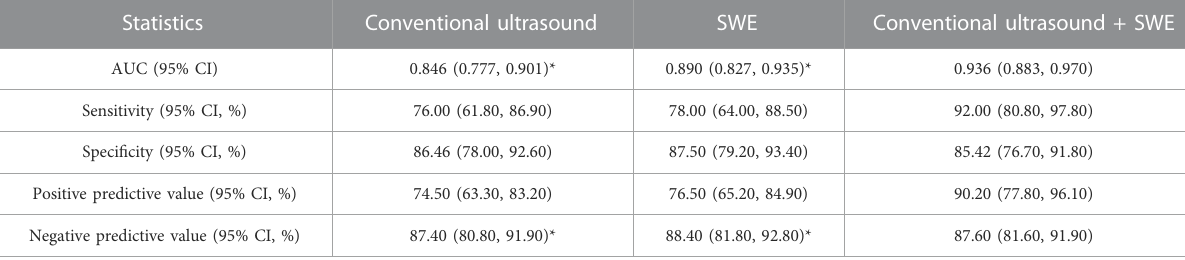
TABLE 5 Comparison of the diagnostic value of Conventional ultrasound, SWE, and Conventional ultrasound + SWE.